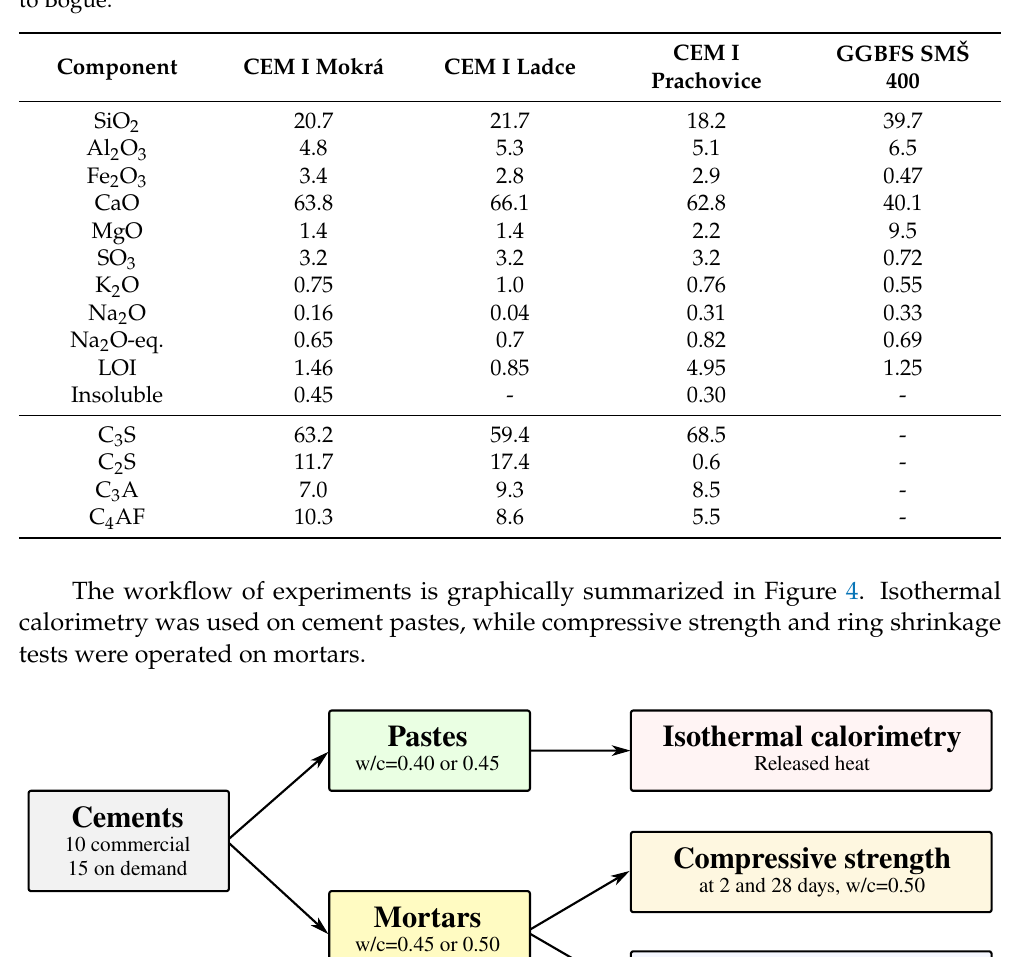
Table 1. Chemical composition of selected cements and approximate mineral composition according to Bogue.